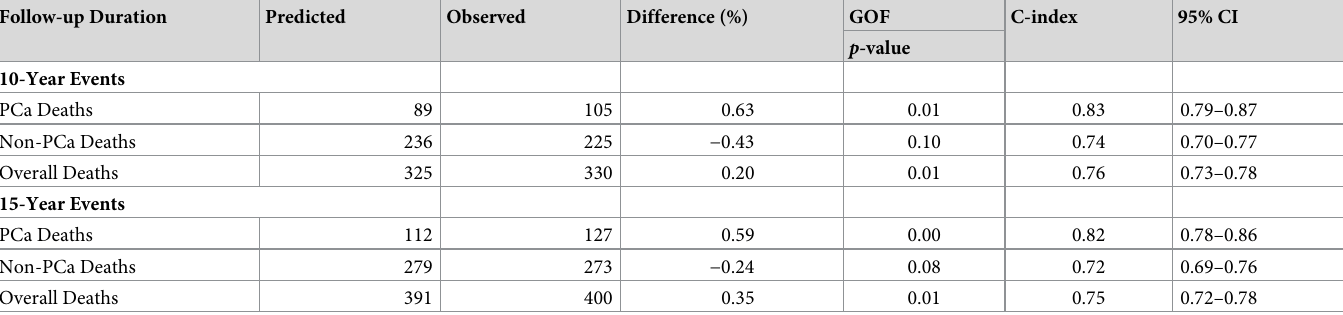
Table 5. Observed and predicted deaths over 10 and 15 years in the Singaporean validation cohort ( n = 2,546). GOF and C-index are shown for each cause of